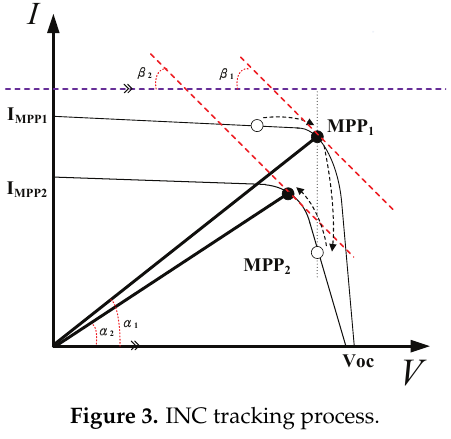
Figure 3. INC tracking process.